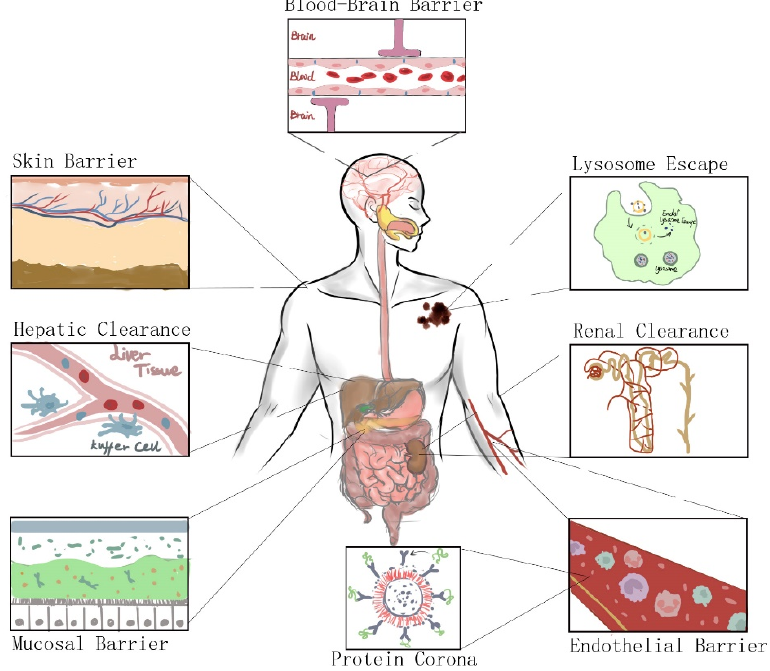
Figure 3. Physiological barriers to systemic and topical drug therapy.